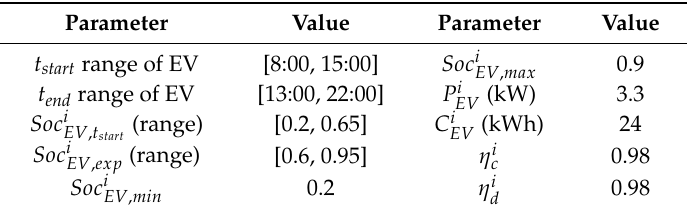
Table 1. Simulation parameters.